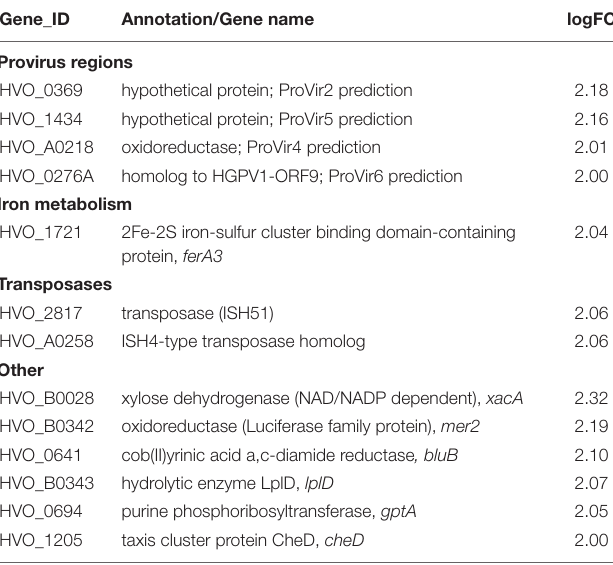
TABLE 1 | RNA expression profile of the (cid:49) cas1 (cid:49) fen1 deletion mutant compared to the wild-type.